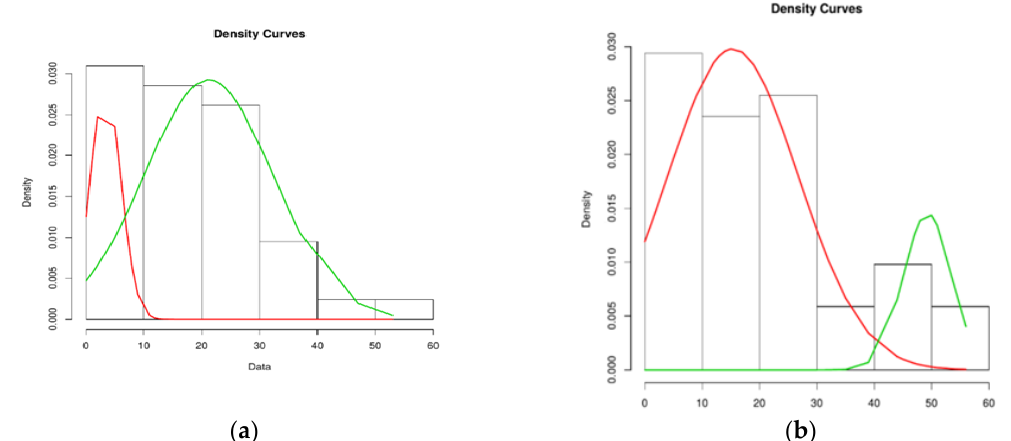
Figure 8. The output of the EM algorithm for the ( a ) left direction towards Igoumenitsa; ( b ) right direction towards Ioannina.